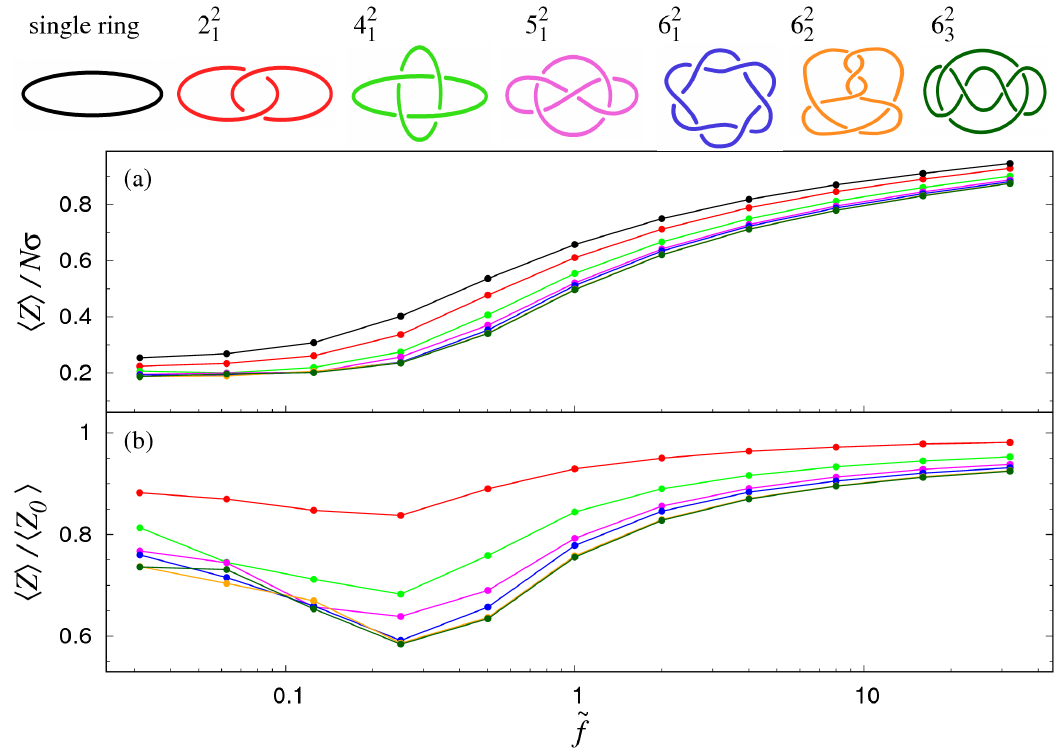
Figure 4. ( a ) Force–extension curves of pairs of rings interlocked in different types of topological links. Each ring consists of N = 120 beads of nominal diameter σ . The average longitudinal extension along the pulling direction is indicated as (cid:104) Z (cid:105) . In panel ( a ) the longitudinal extension is divided by N σ , which is twice the maximum extension of an individual ring. In panel ( b ) the longitudinal extension of the link is divided by the average extension of a single ring of equivalent contour length, 2 N σ , at the same applied